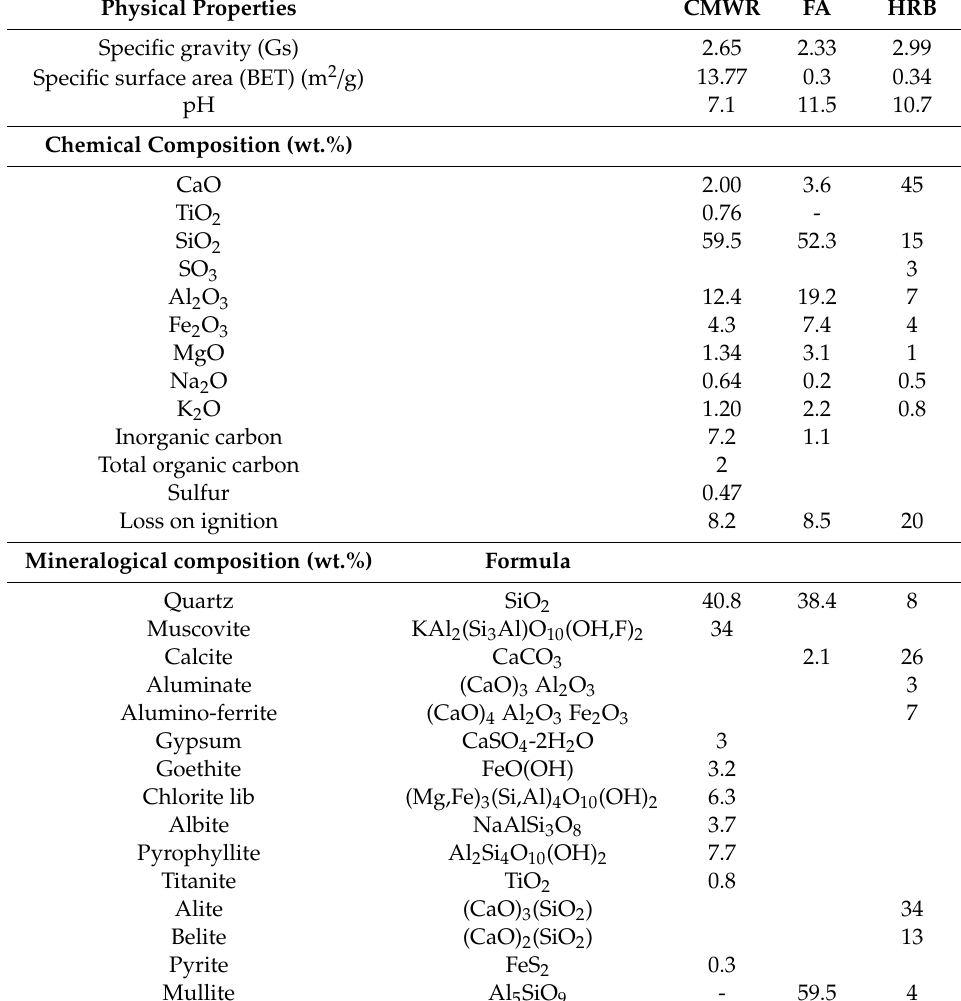
Table 4. Physical, chemical and mineralogical composition of CMWR, FA, and HRB materials. Physical